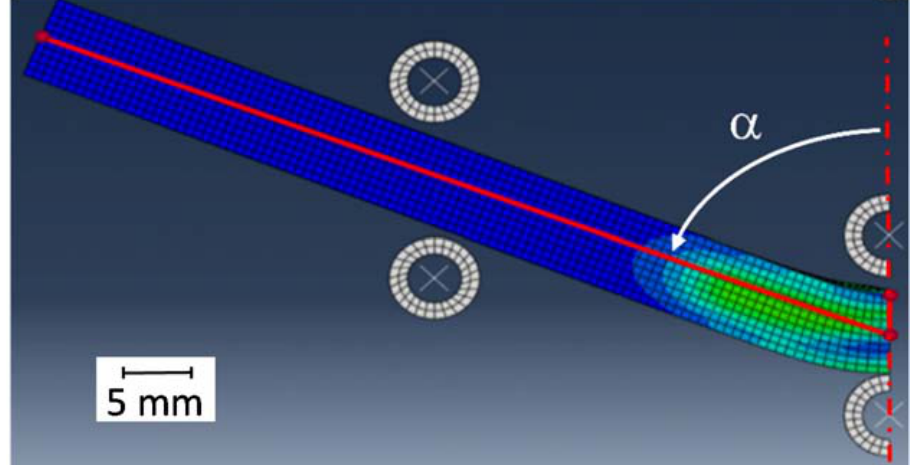
Figure 9. Determination of the bending curvature in the simulations. The curvature calculated in this way is 138 ◦ compared to 140 ◦ measured in the experiment. This shows that the hardening of the material and the associated springback after free bending can be reproduced well with the MJC model. The maximum force predicted by the two models during each bending cycle is shown with the experimental data in Figure 10.